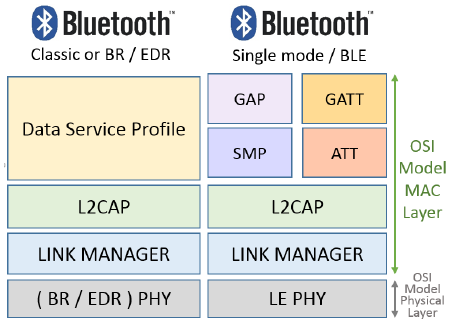
Figure 8. Bluetooth power class